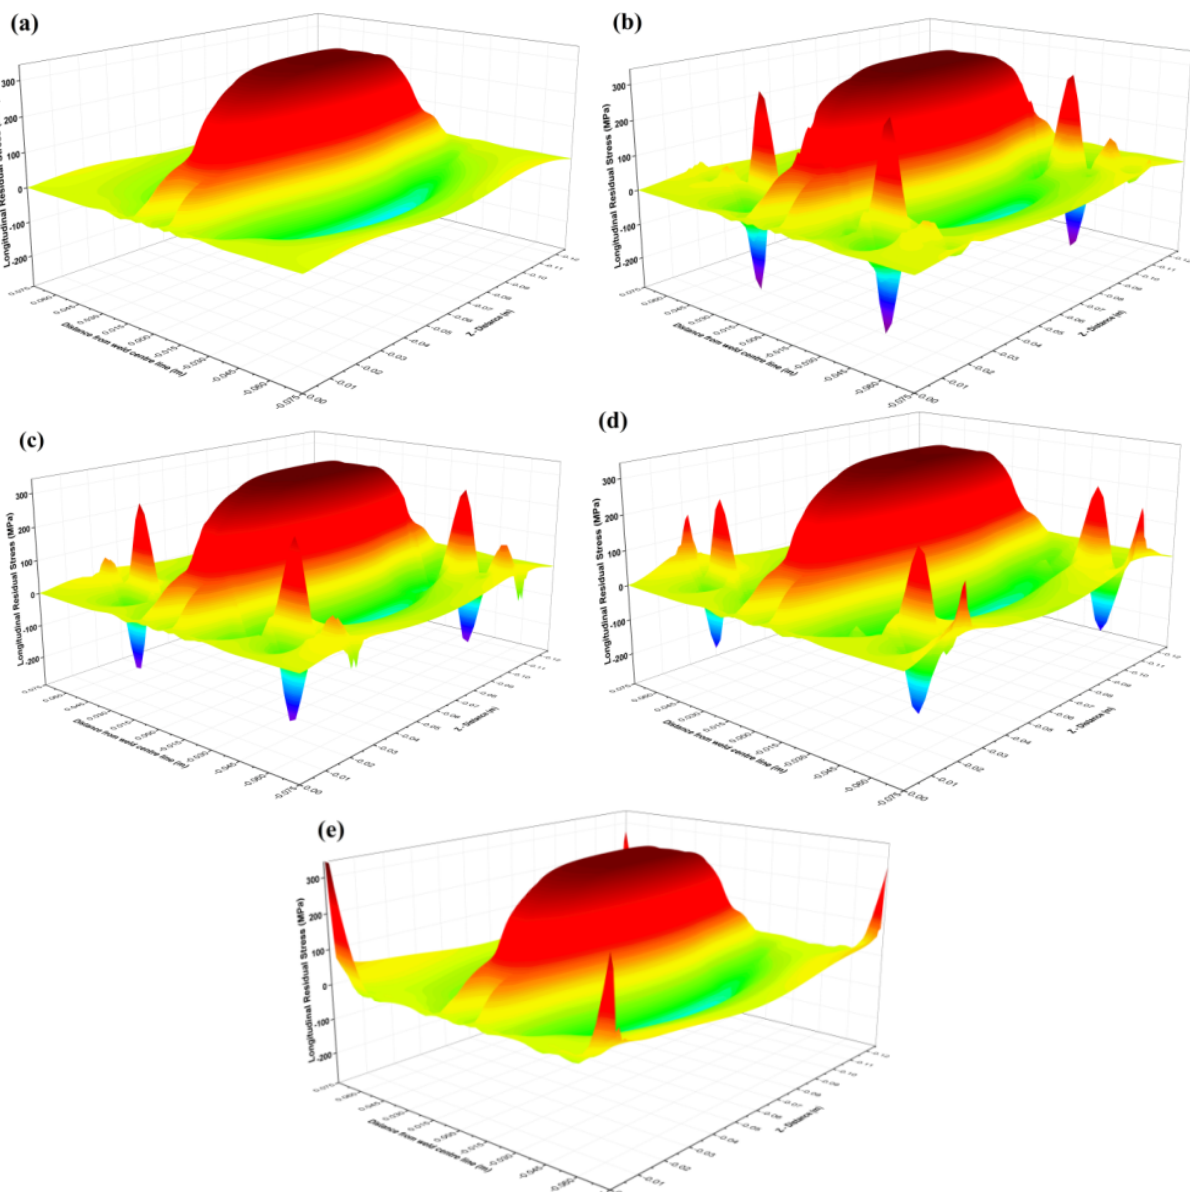
Figure 11: Predicted longitudinal residual stress distribution in top surface of the plate (a) Case ‘A’, (b) Case ‘B’, (c) Case ‘C’, (d) Case ‘D’, (e) Case